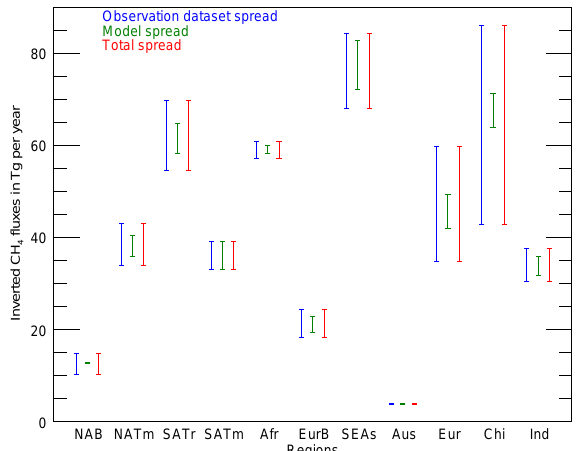
Figure 6. Spreads (maximum − minimum) in regional methane es- timates (inTgCH 4 year − 1 ) due to the choice of the observation data set (blue error bars) and due to the choice of the model version (green error bars). The total spreads in the nine inversions run in this work are plotted in